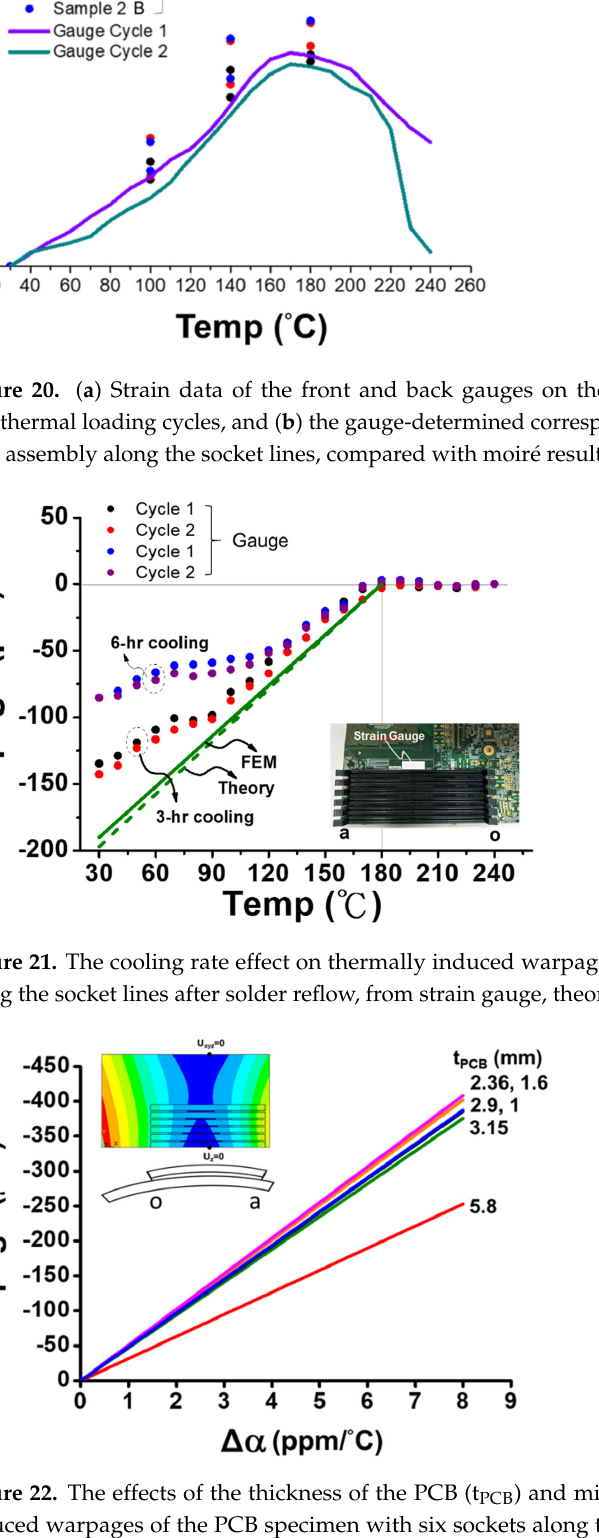
Figure 23. The e ff ects of the thickness of the PCB (t PCB ) and mismatch of CTE ( Δα ) on thermally induced warpages at the corner of the PCB for the socket-PCB assembly with 24 sockets from the FEM simulation Δ T= 30 °C − 180 °C = − 150 °C. 4. Conclusions The problem of thermal warpage for the DIMM socket-PCB assembly after the solder re fl ow processes has been extensively investigated experimentally, theoretically, and nu- merically, especially along the socket lines and over the entire assembly. In this study, a beam-like theoretical solution to this problem has been newly proposed by modifying the existing Suhir theory. The theoretical solution validated by the fi nite element method (FEM) simulation has provided the detailed mechanics, including the critical parameters, such as the coe ffi cient of thermal expansion (CTE, α ), elastic modulus (E 2 ), thickness (t 2 ) of the e ff ective material (which is a combined material of a solder joint and Cu pin), and width of the PCB. The CTEs of the socket and the bare PCB have been obtained as 14 and 18 ppm/°C by the strain gauge measurement, respectively. However, inconsistent data for the CTE were found for the sockets in the measurement of the fi rst thermal cycle, but the CTE became constant after the fi rst thermal cycle. Meanwhile, the e ff ective elastic moduli of the socket and the combined material of solder joint and Cu pin have been determined